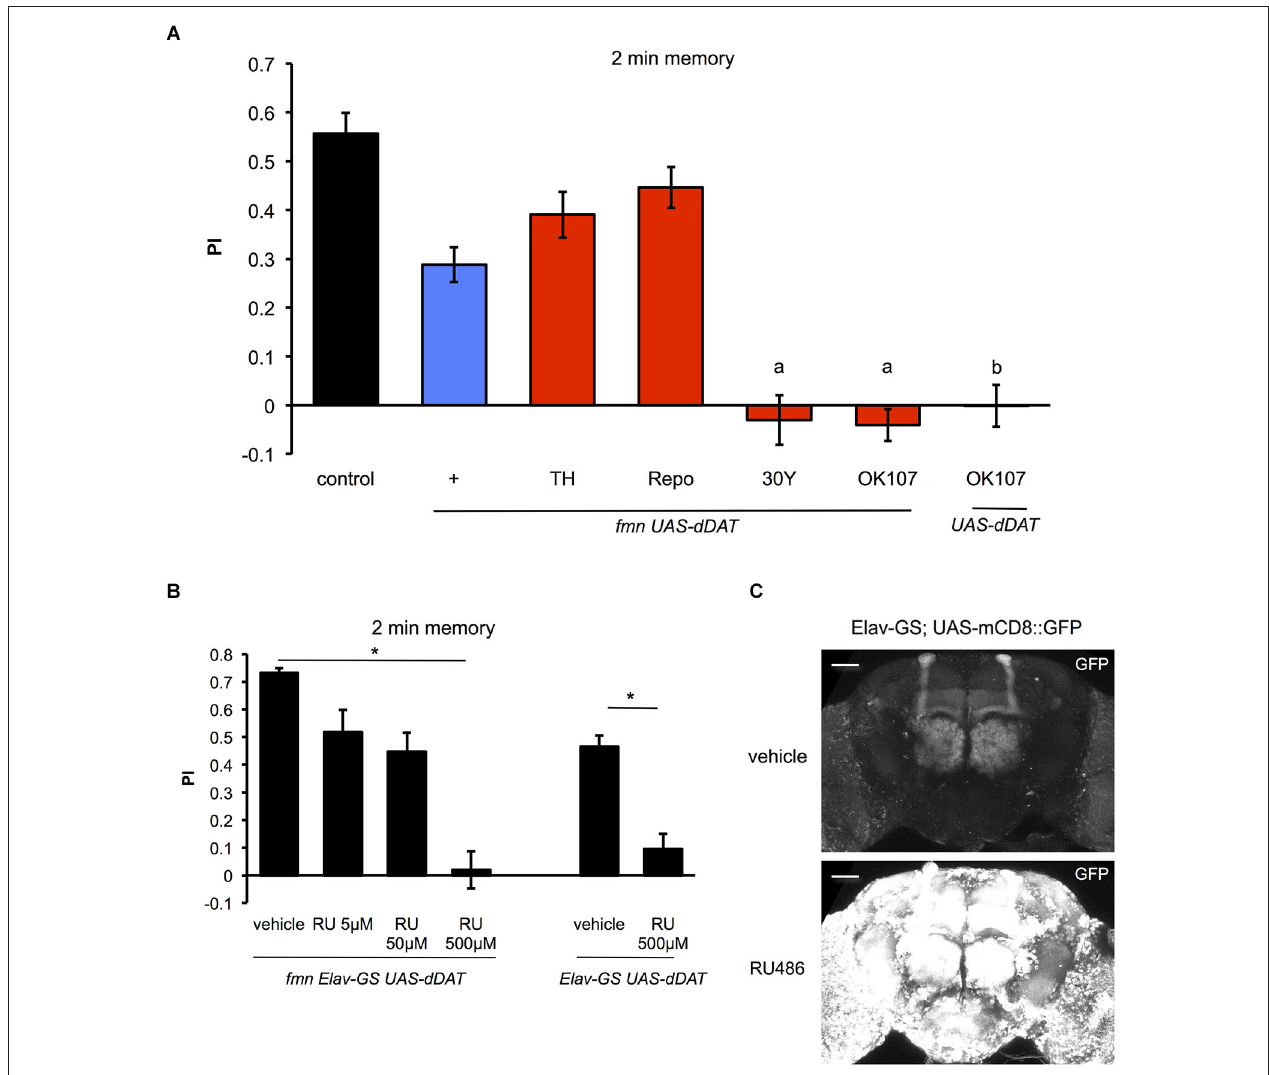
FIGURE 6 | Effect of dDAT expression on memory. (A) The results of the 2 min memory (immediate memory) tests for each genotype are shown. Each genotype ( n = 8–17 trials) was tested using an aversive olfactory conditioning test after training. Data are represented as the mean ±